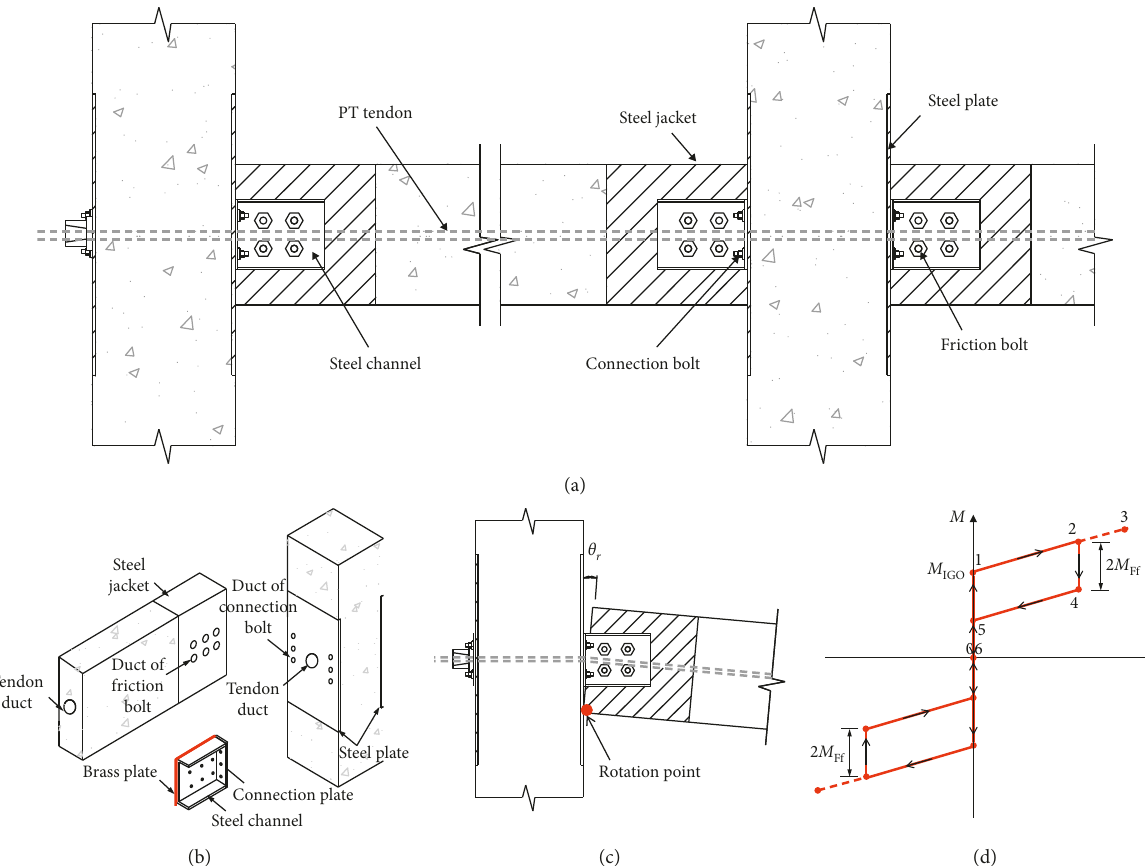
Figure 1: SC concrete frame with web friction devices. (a) Profile of the SC frame. (b) Configuration of beam-column connection. (c) Gap- opening behavior. (d) Conceptual M − θ r